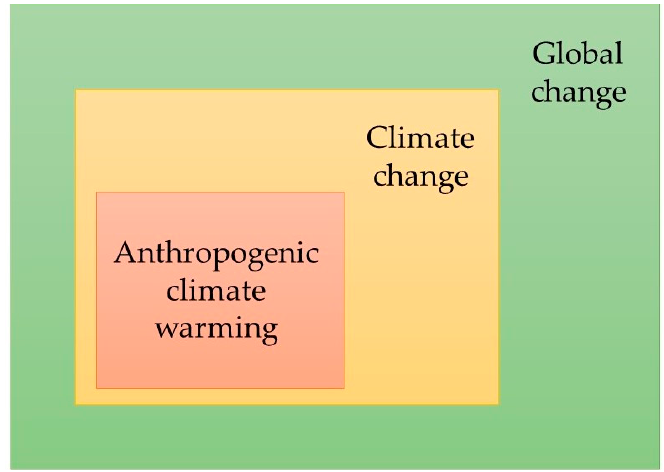
Figure 2. Outline of the concepts used in climate change. Source: modification of Martín-Vide 2009, 64.